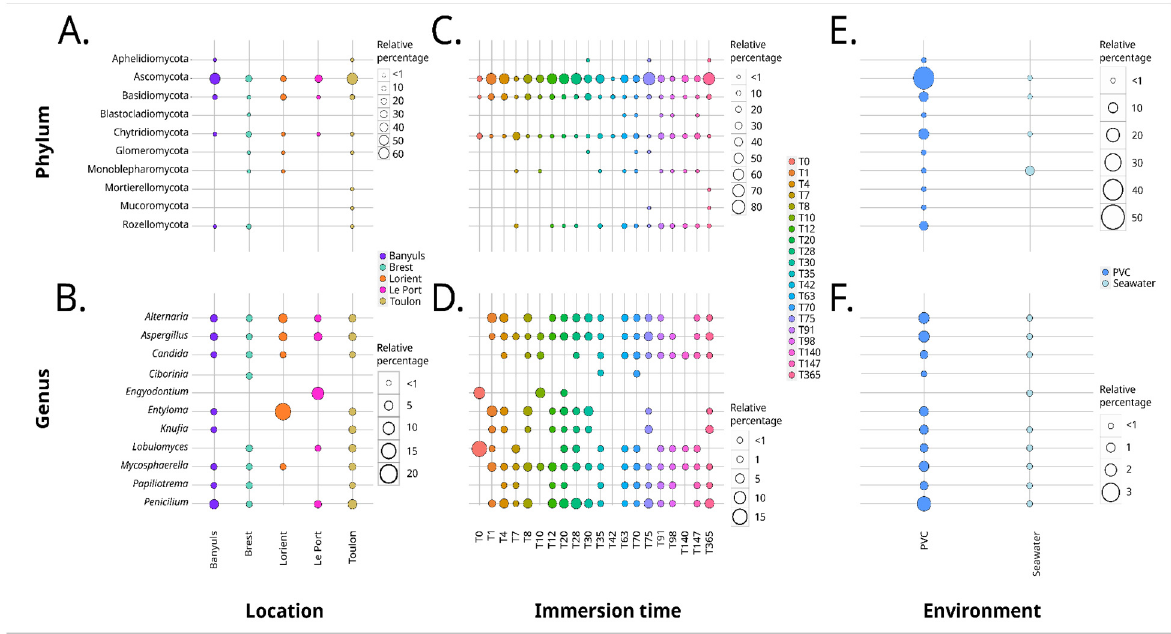
Figure 4. Bubble-plot representing the proportions of phyla or genus, based on the ITS2 dataset, according to the variables ( A , B ) “Location”. ( C , D ) “Immersion time” (days). ( E , F ) “Environment”. The listed genera correspond to the 10 most abundant genera, also containing 2 genera identified as differentially abundant using ANCOM ( Alternaria and Engyodontium ), and one extra genus that was also highlighted by ANCOM ( Ciborinia ).